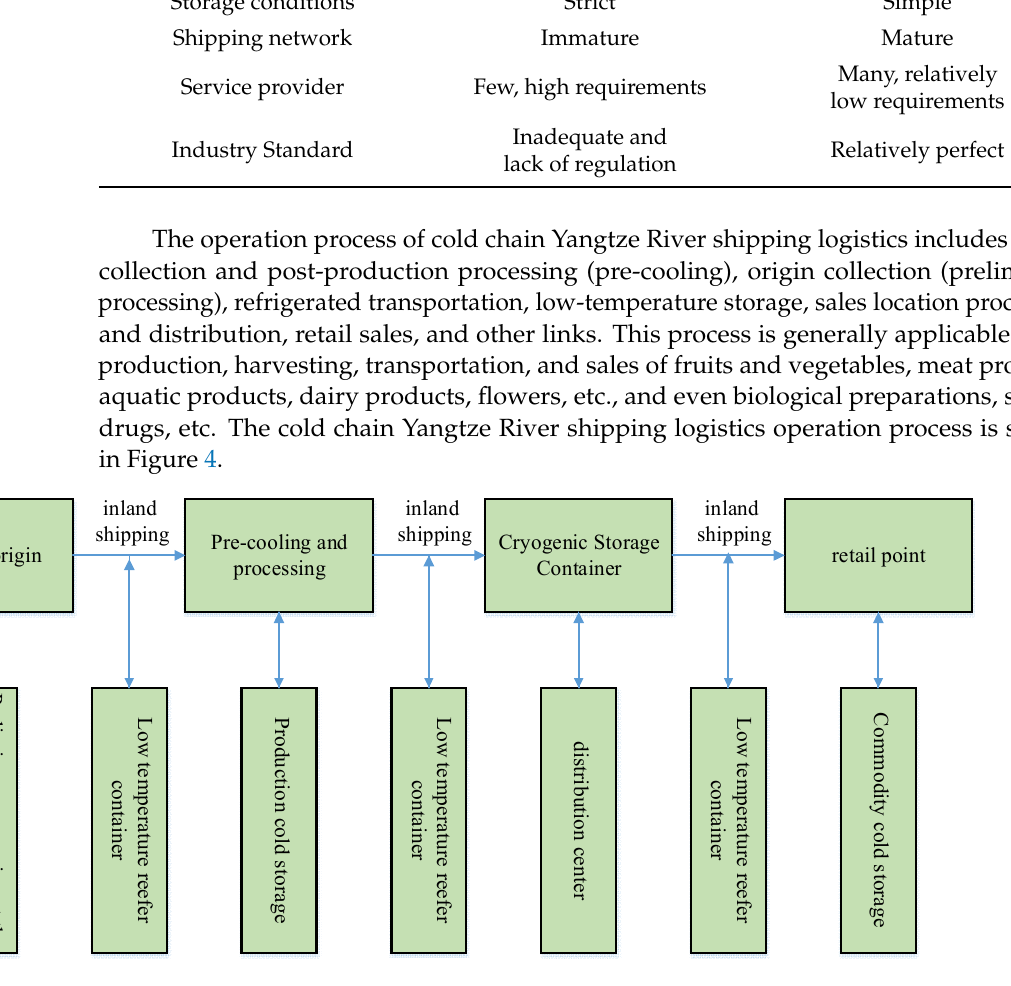
Figure 4. The cold chain Yangtze River shipping logistics operation process.